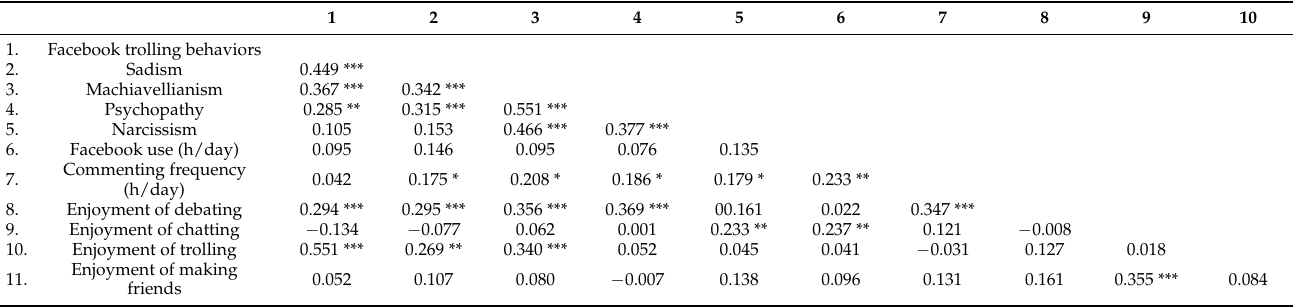
Table 3. Associations of Facebook trolling behaviors and Dark Tetrad variables with commenting behavior and